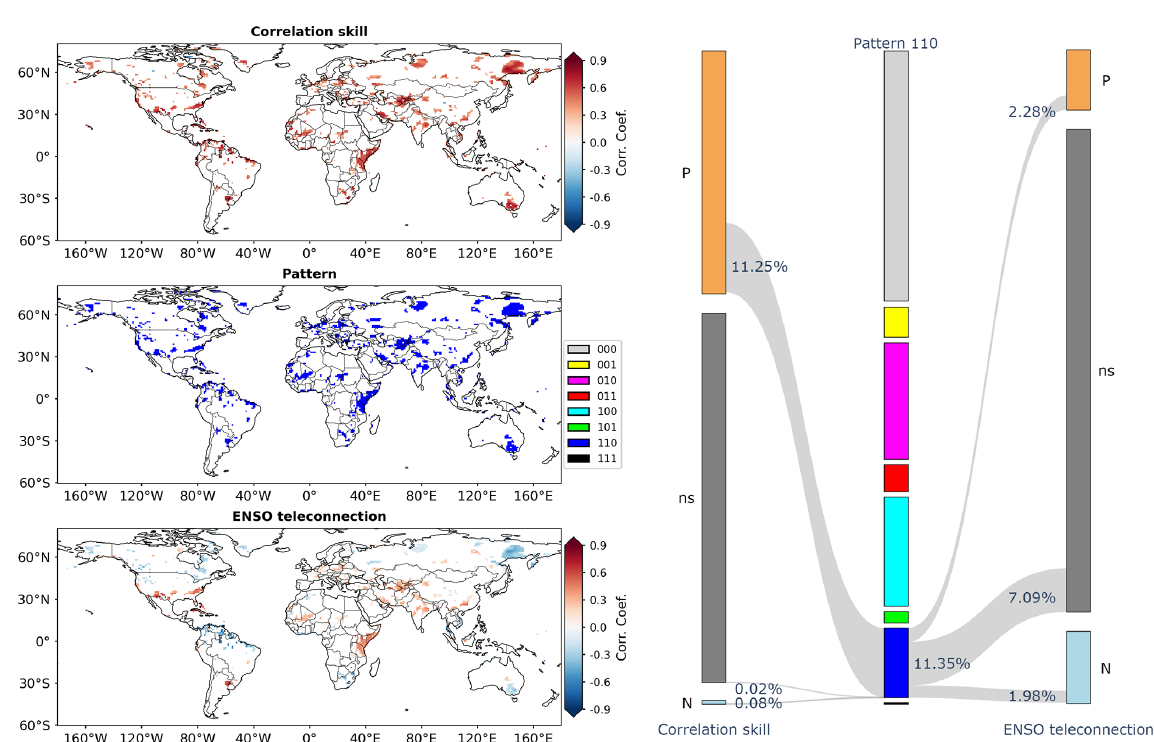
Figure 6. As for Fig. 4 but for pattern 110.